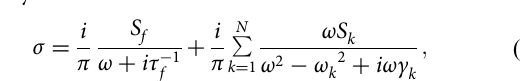
Fig. 7. Then, the maxima of the loss function in the map are extracted as the iso-frequency contour in q -space, as shown in Fig. 3b. All of them exhibit hyperbolic shapes. The direction of the group velocity is the direction of the polariton energy fl ow. It usually doesn ’ t align with q direction in anisotropic materials. Indeed, the direction of the group velocity is orthogonal to the q - space iso-frequency contour 17,48 . The angles θ labeled in Fig. 3b are the directions of the asymptote of the iso-frequency curves.